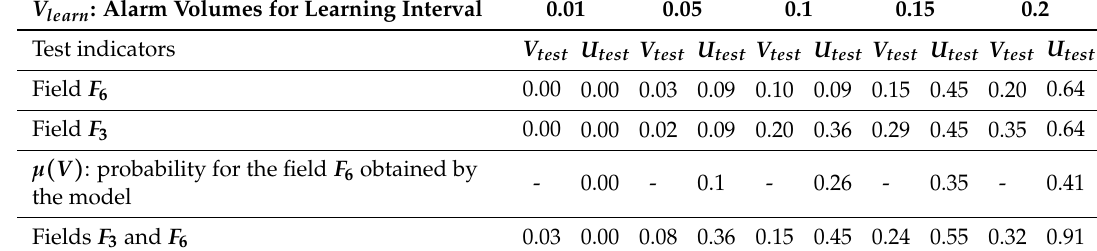
Table 1. Comparison of the probabilities of earthquake forecast for the Mediterranean. V learn : Alarm Volumes for Learning Interval